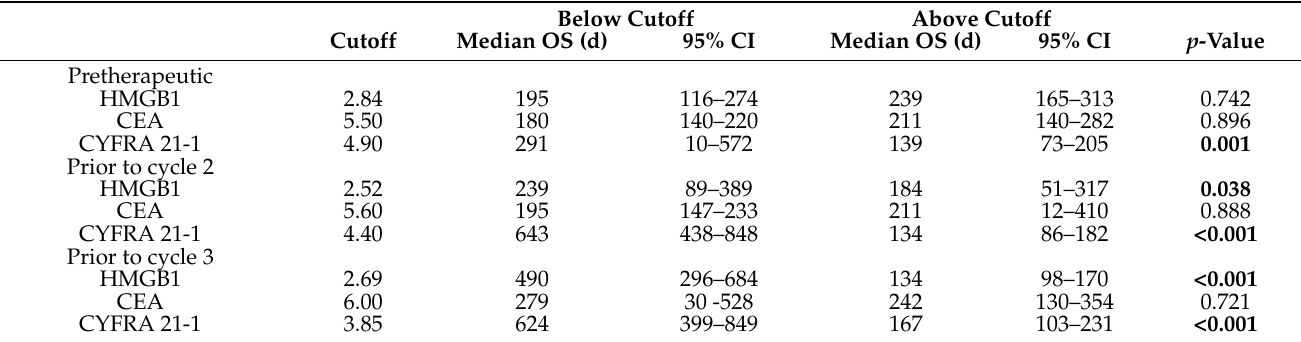
Table 5. Performance of biomarkers for prognosis of overall survival. Below Cutoff Above Cutoff Cutoff 95% CI Median OS (d) p